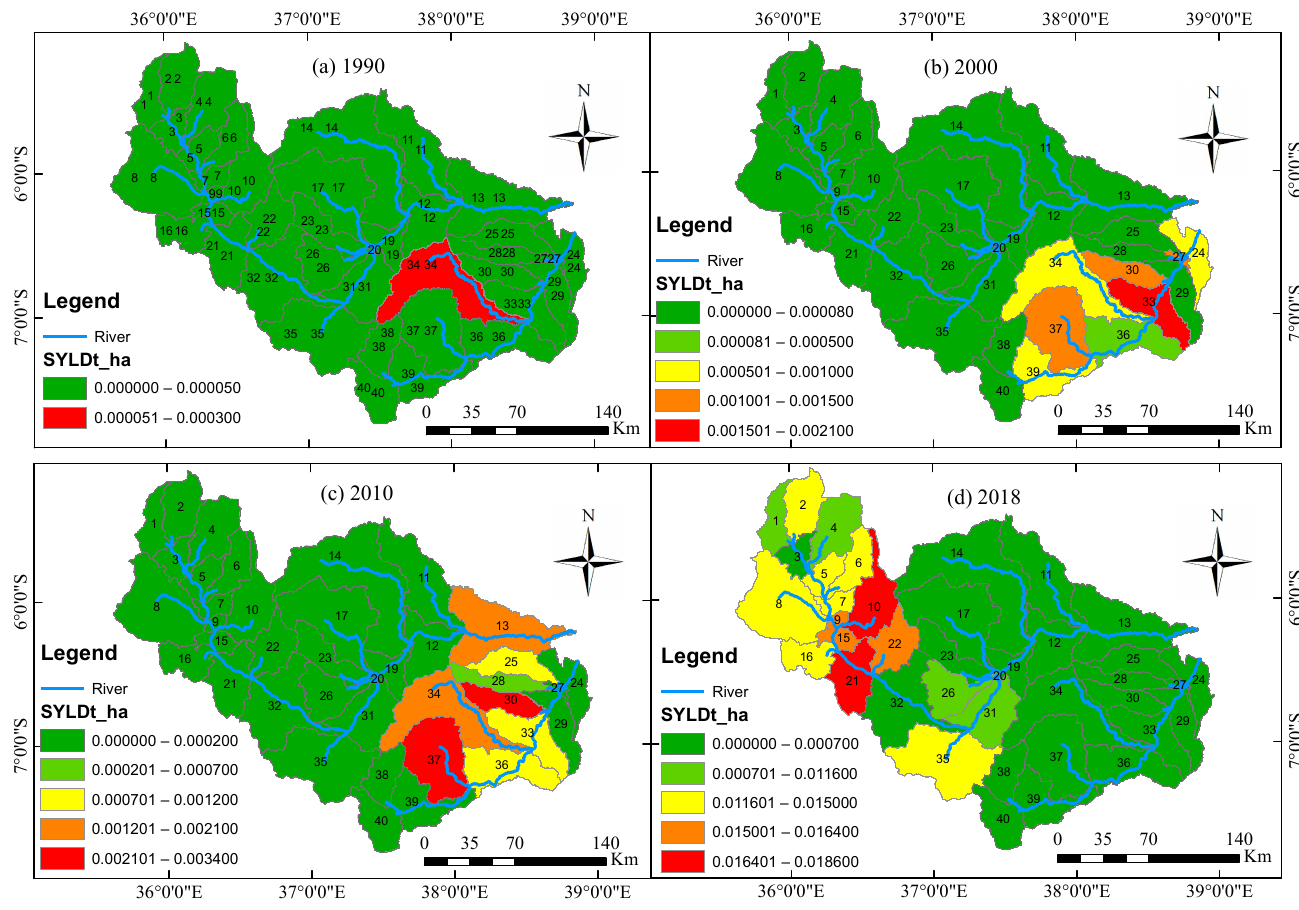
Figure 13. The simulated spatial pattern of SYLD in the WRB for the years ( a ) 1990, ( b ) 2000, ( c ) 2010 and ( d ) 2018. Table 10. The ranking of the seven most sensitive parameters and their final values. Rank